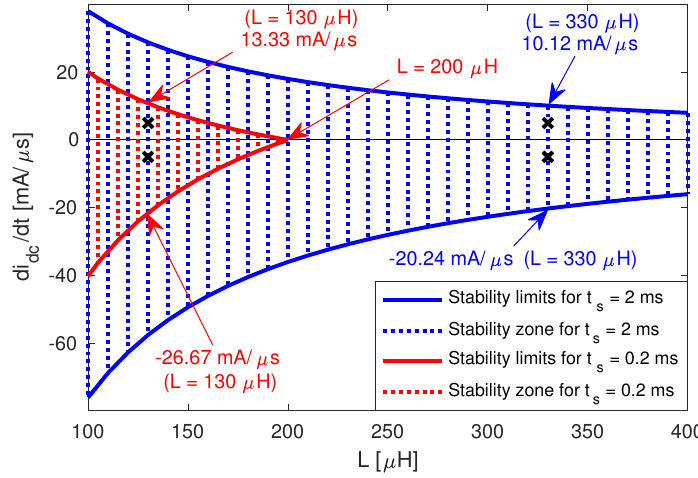
Figure 5. Plot for inductor